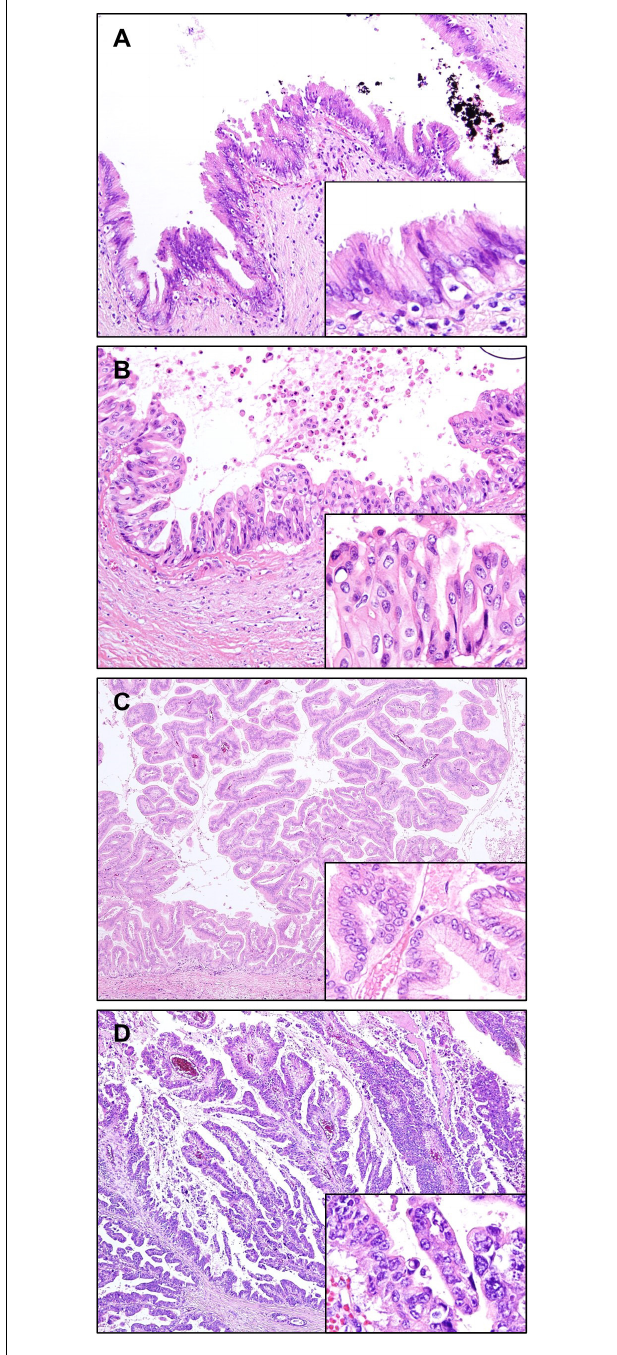
FIGURE 4 | Precursor lesions of intrahepatic cholangiocarcinoma. (A,B) Biliary intraepithelial neoplasia (BilIN). (A) Low-grade BilIN composed of columnar cells with intact nuclear polarity and minimal atypia. (B) High-grade BilIN showing stratification of cells with marked nuclear atypia and loss of polarity. (C,D) Intraductal papillary neoplasm of the bile ducts (IPNB). (C) Low-grade IPNB showing a papillary growth of columnar biliary type epithelial cells with mild pleomorphism and preserved nuclear polarity. (D) High-grade IPNB showing irregular papillary projections, composed of highly pleomorphic and stratified cells with increased nuclear-cytoplasmic ratio. Original magnification: 100 × for (A,B) , 40 × for (C,D) , 200 × for inset